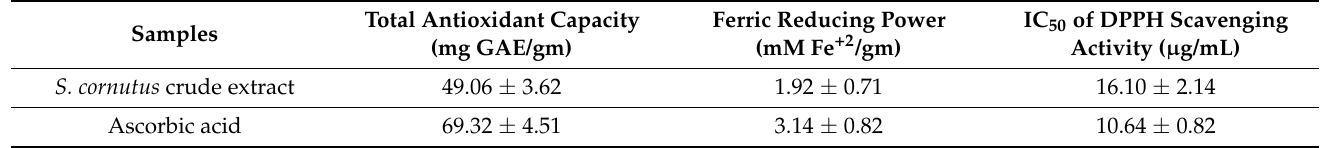
Table 3. Total antioxidant capacity, ferric reducing power activity, and DPPH free radical scavenging activity of S. cornutus